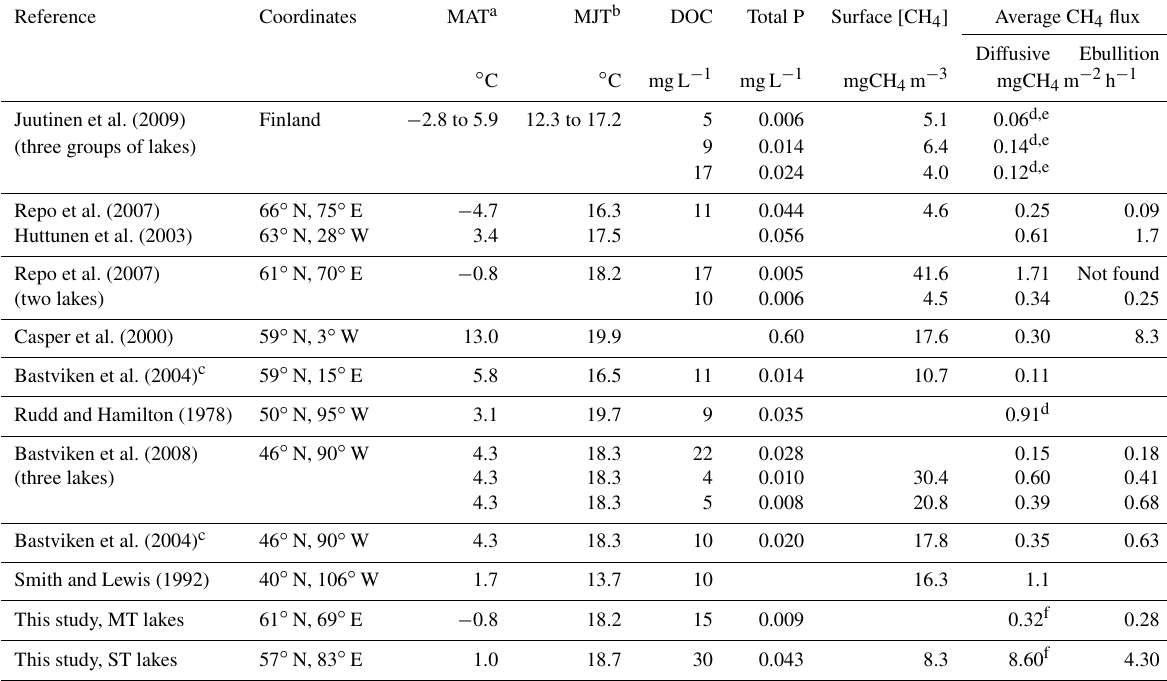
Table 5. Summary for temperate and boreal lakes with an area < 100ha. Empty cells mean no data; storage fluxes are not shown and do not have values more than 1mgCH 4 m − 2 h − 1 .